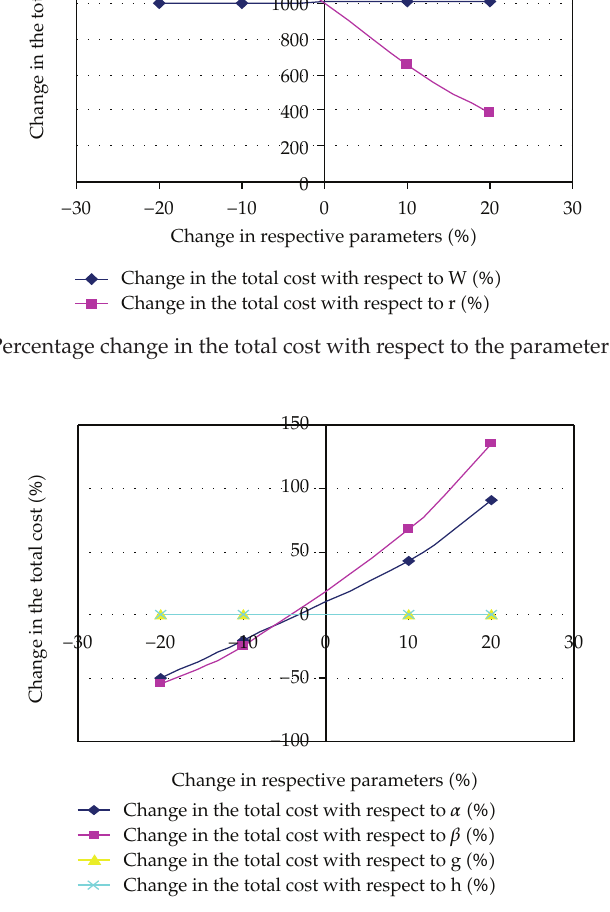
Figure 7: Percentage change in the total cost with respect to the parameters α,β,g , and h